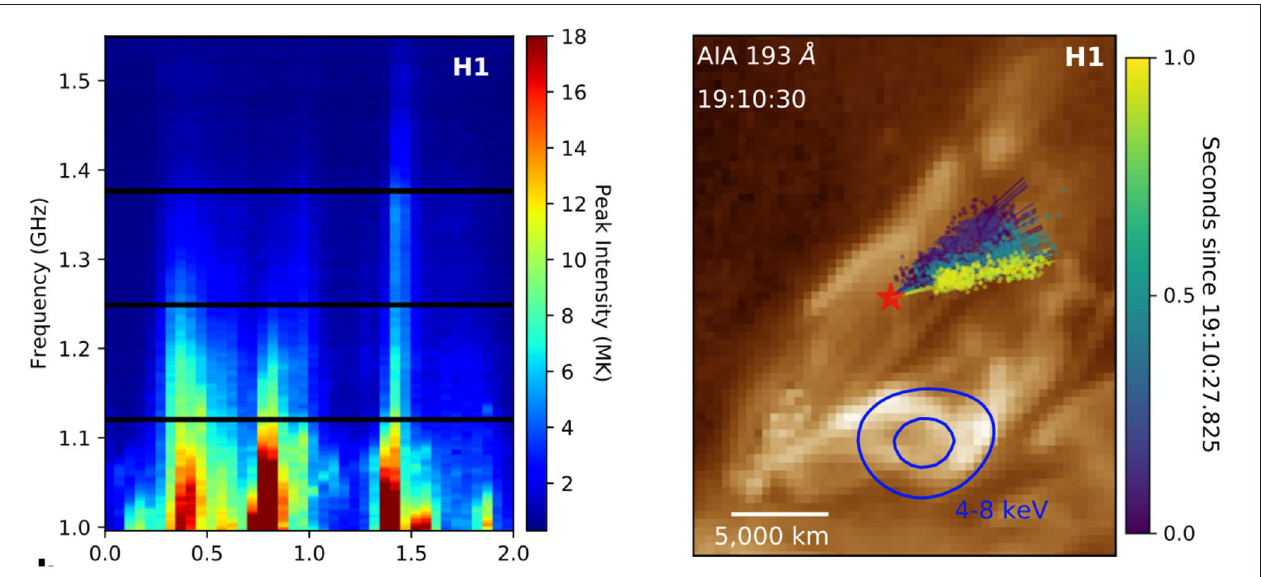
FIGURE 2 | Left : VLA dynamic spectrum of a series of type III radio bursts. Right : The electron beam trajectories fit over the type III centroids, showing a systematic change in the spatial motion. All trajectories lead to a common acceleration region, denoted by the red star. Both panels adapted from Chen B. et al. (2018).